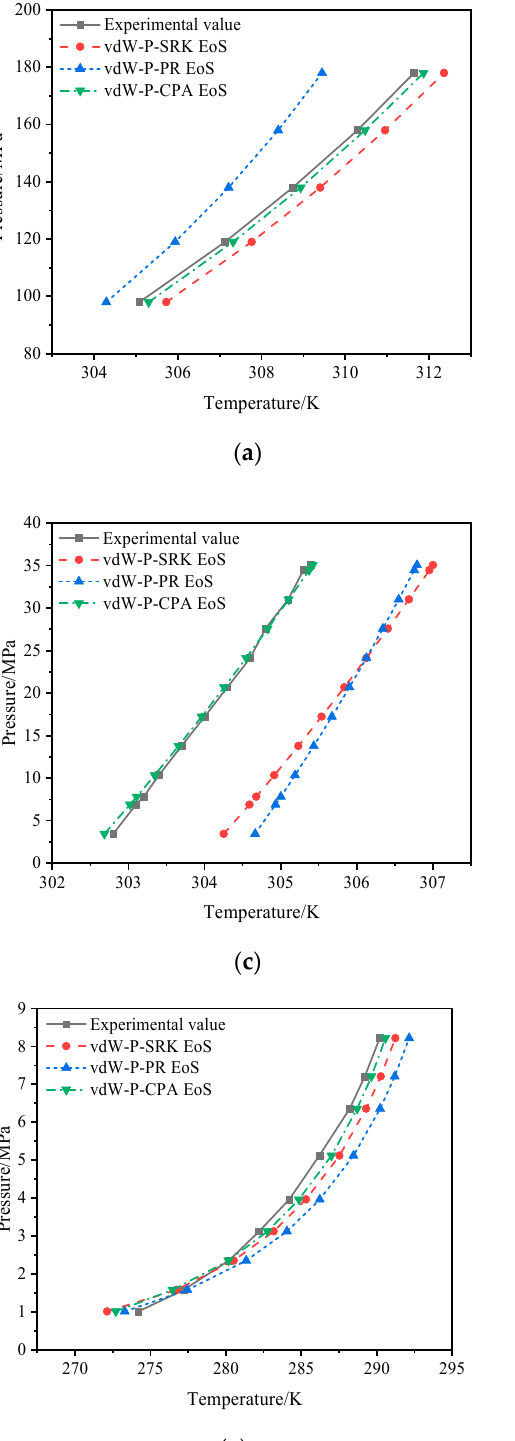
P model and CPA EoS show a high consistency with the experimental data for all systems.